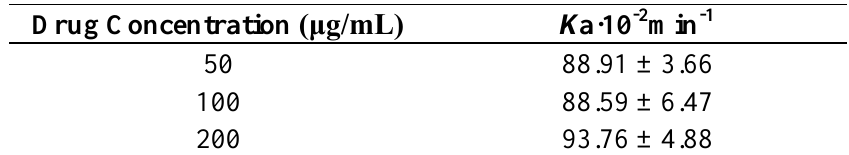
Table 4. K a of paeonol nasal absorption with different drug concentrations ( n = 5, mean ±